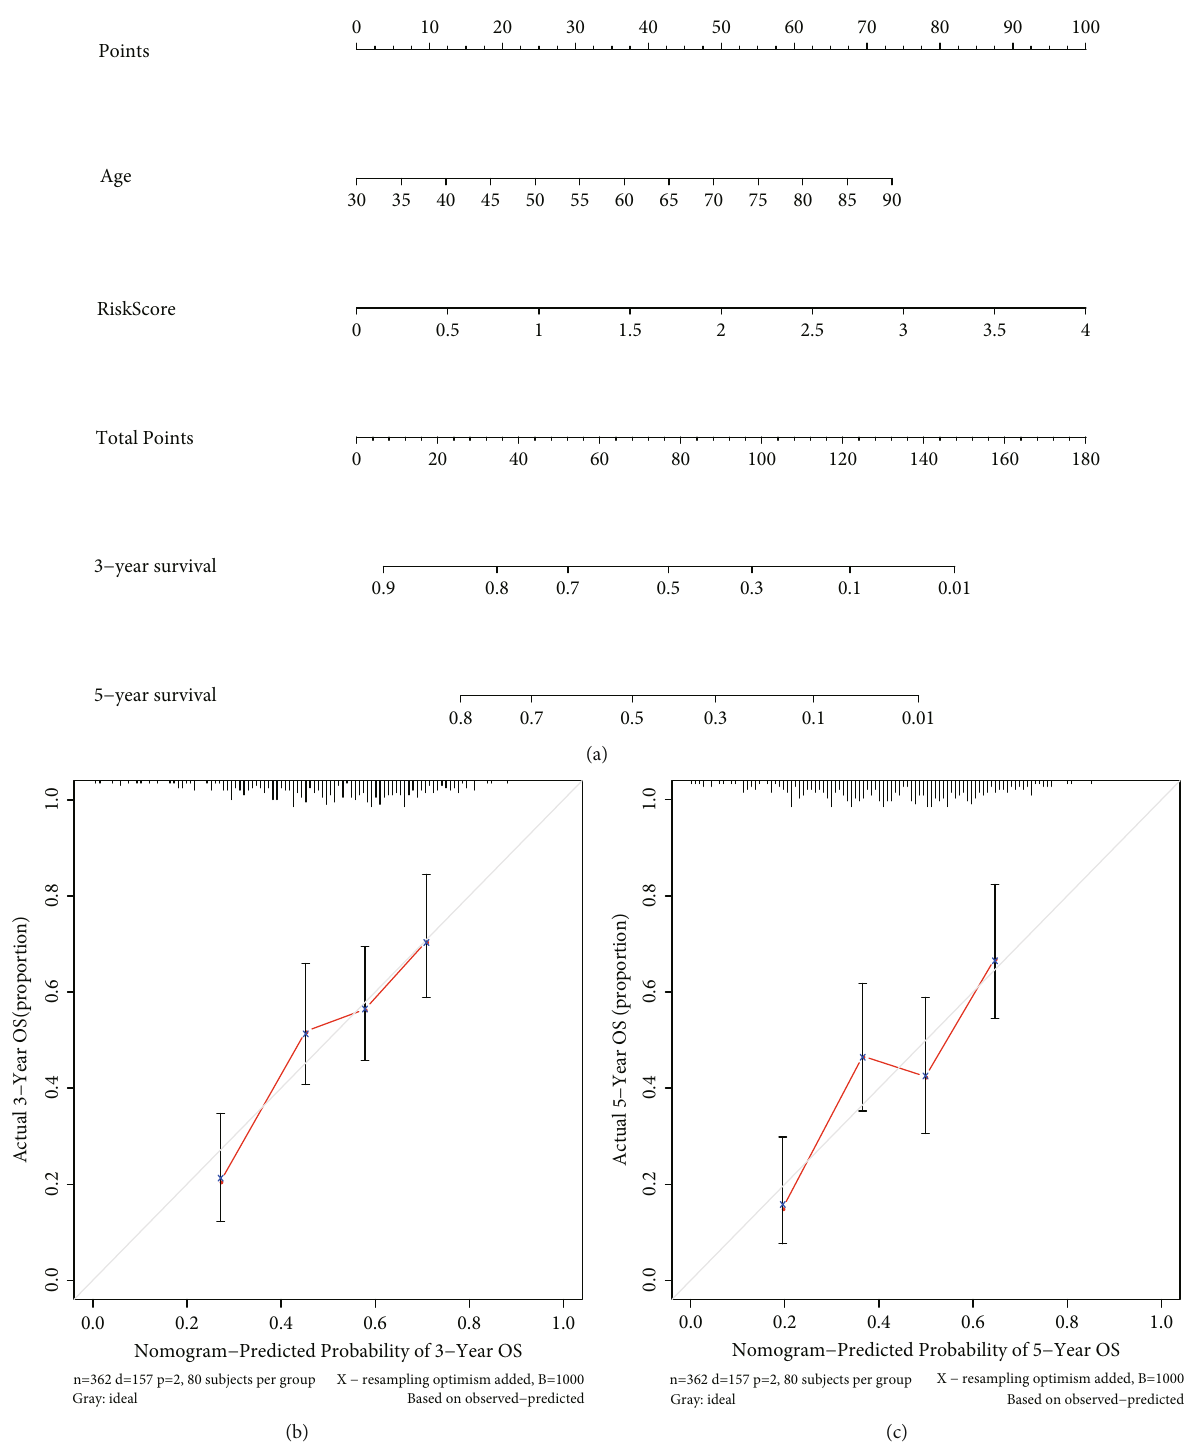
Figure 10: Establishment of the nomogram in the TCGA dataset. (a) Nomogram based on the PPARscore and age; (b) the 3-year calibration plot for the nomogram; (c) the 5-year calibration plot for the